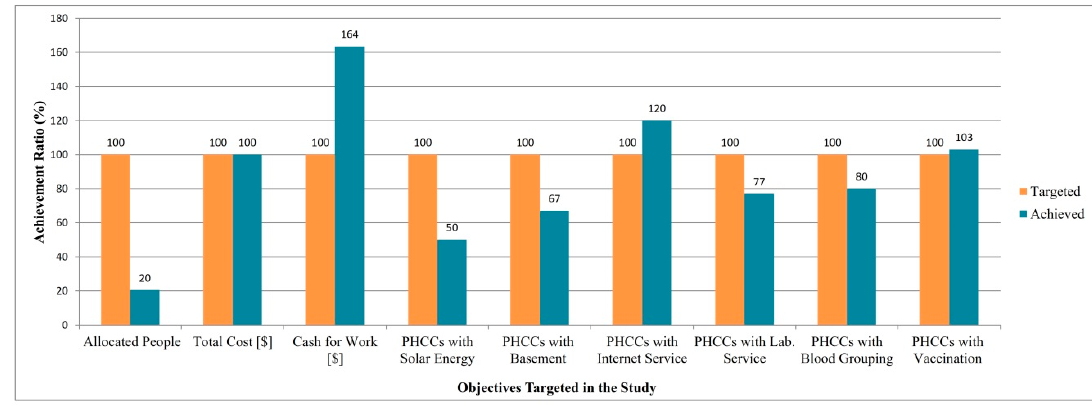
Figure 4. Outputs achieved in the study as a percentage of the targeted level.